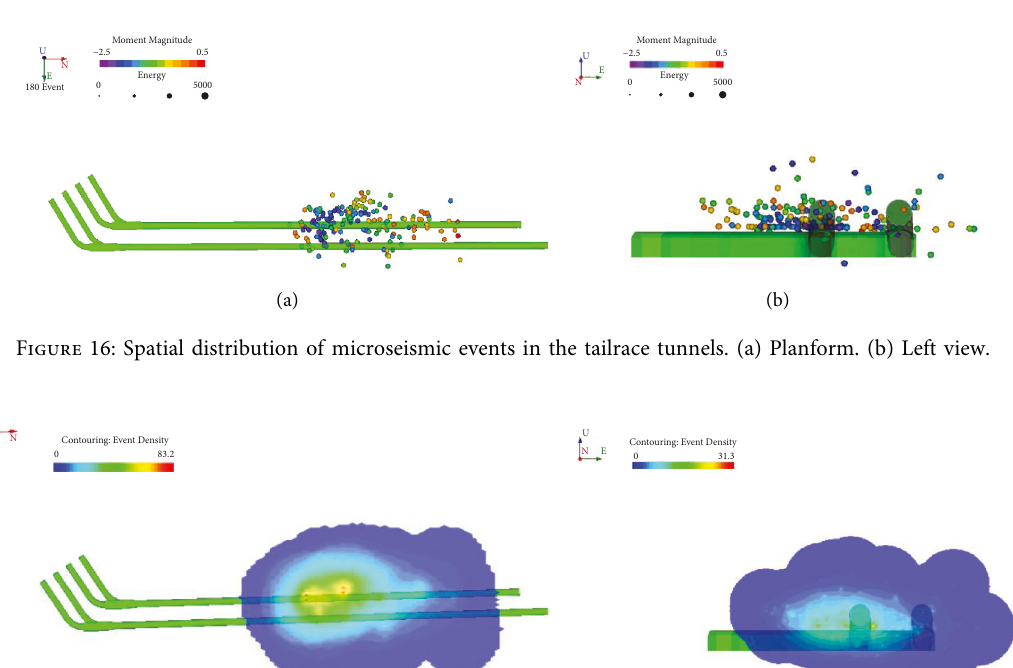
y = -1.66 x + 0.32 R 2 = 0.96